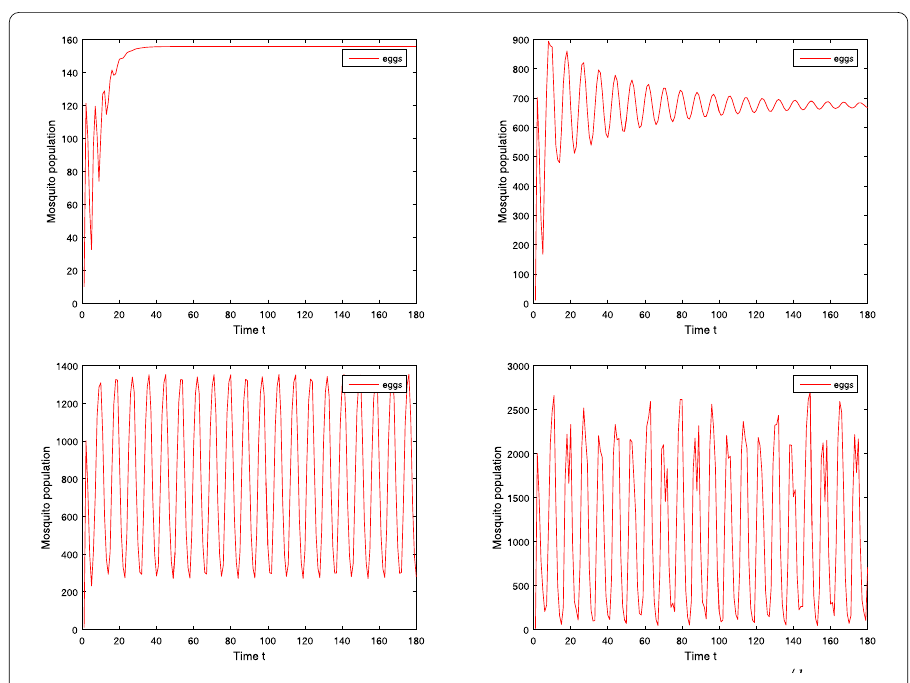
Figure 4 The function s i ( x ) has the Ricker-type form such that s i ( x ) = a i e – x / ki , i = 1,2,4, with the parameters a 1 = 0.7, a 2 = 0.4, s 3 = 0.68, a 4 = 0.2, k 1 = 300, k 2 = 350, k 4 = 500, r 1 = 0.8, r 2 = 0.8, r 3 = 0.8, As b = 12, (cid:2) 0 = 2.1391. The positive fixed point is globally asymptotically stable, as shown in the upper left figure. As b = 70, (cid:2) 0 = 12.4780. The solution appears to oscillate, as shown in the upper right figure. As b = 100, (cid:2) 0 = 17.8257, and a cycle with period exists, as shown in the lower left figure. As b = 200, the system exhibits chaotic behavior, as shown in the lower right figure. All populations shown in the figures are only eggs for clearer